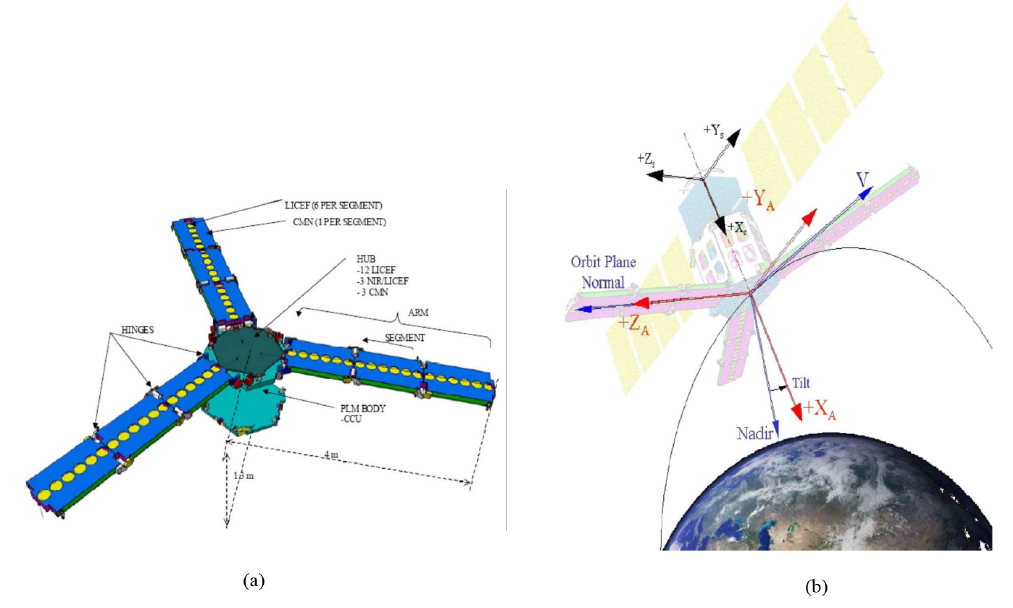
Figure 1. The payload MIRAS [9]. ( a ) Deployed MIRAS configuration diagram. ( b ) Measurement mode observation